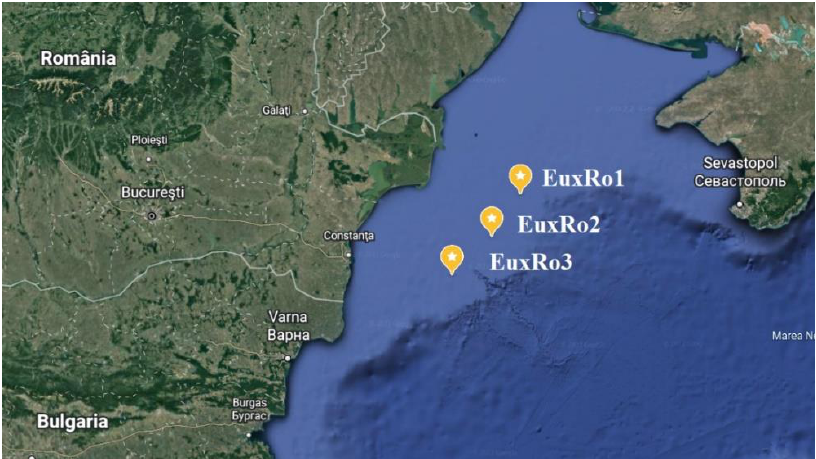
Figure 3. Positions of the GeoEcoMar buoys in the Black Sea. Table 1. Positions of the buoys in the Black Sea.